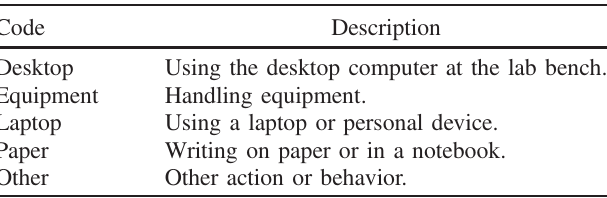
TABLE II. Action codes used in observations. The laptop code is used for both handling a laptop or personal device (students used laptops, phones, and tablets for the purpose of notetaking, write up, data analysis, and reading instructions in the inquiry labs).